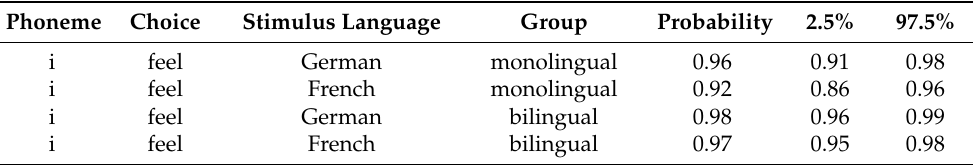
Table 3. Most probable responses given /i/ in French and German by L1 English monolinguals and L1 English bilinguals.